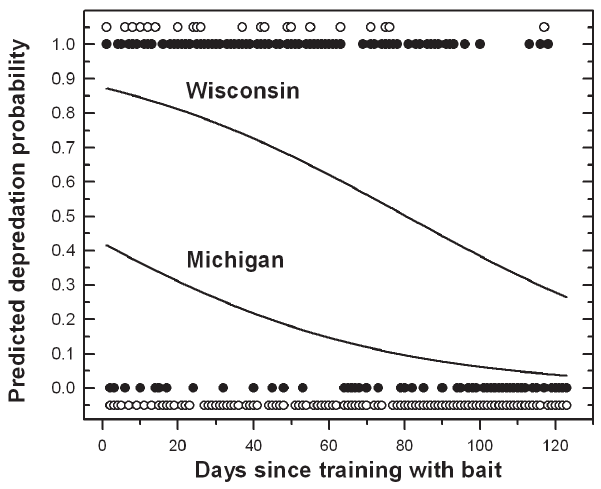
Figure 3. Wolf conflict and the duration of bear-baiting in the upper Great Lakes region, USA. Predicted probability of a wolf depredation on bear-hunting dogs ( y-axis ) versus the number of days since training with bait began ( x-axis ) in Wisconsin ( upper line ) and Michigan ( lower line ). Each point represents a day since training with bait began in Wisconsin ( closed symbols ) and Michigan ( open symbols ). Note that open symbols for Michigan are offset from (0) and (1) probability so as to not overlap symbols for Wisconsin. The odds of a depredation event occurring in Wisconsin were 3.57 6 greater than the odds in Michigan; a relative depredation risk 2.12–7.22 6 greater in Wisconsin.